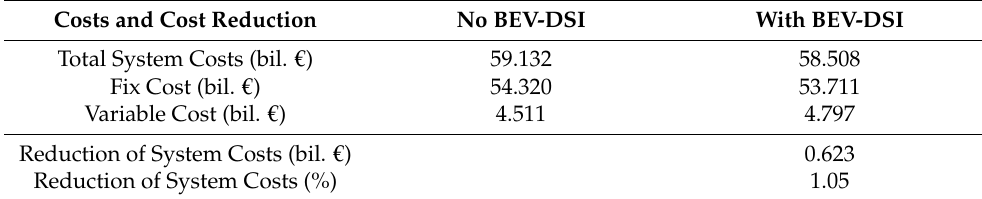
Table 3. Comparison of the resulting costs for the scenario with and without the possibility for BEV-DSI -usage.